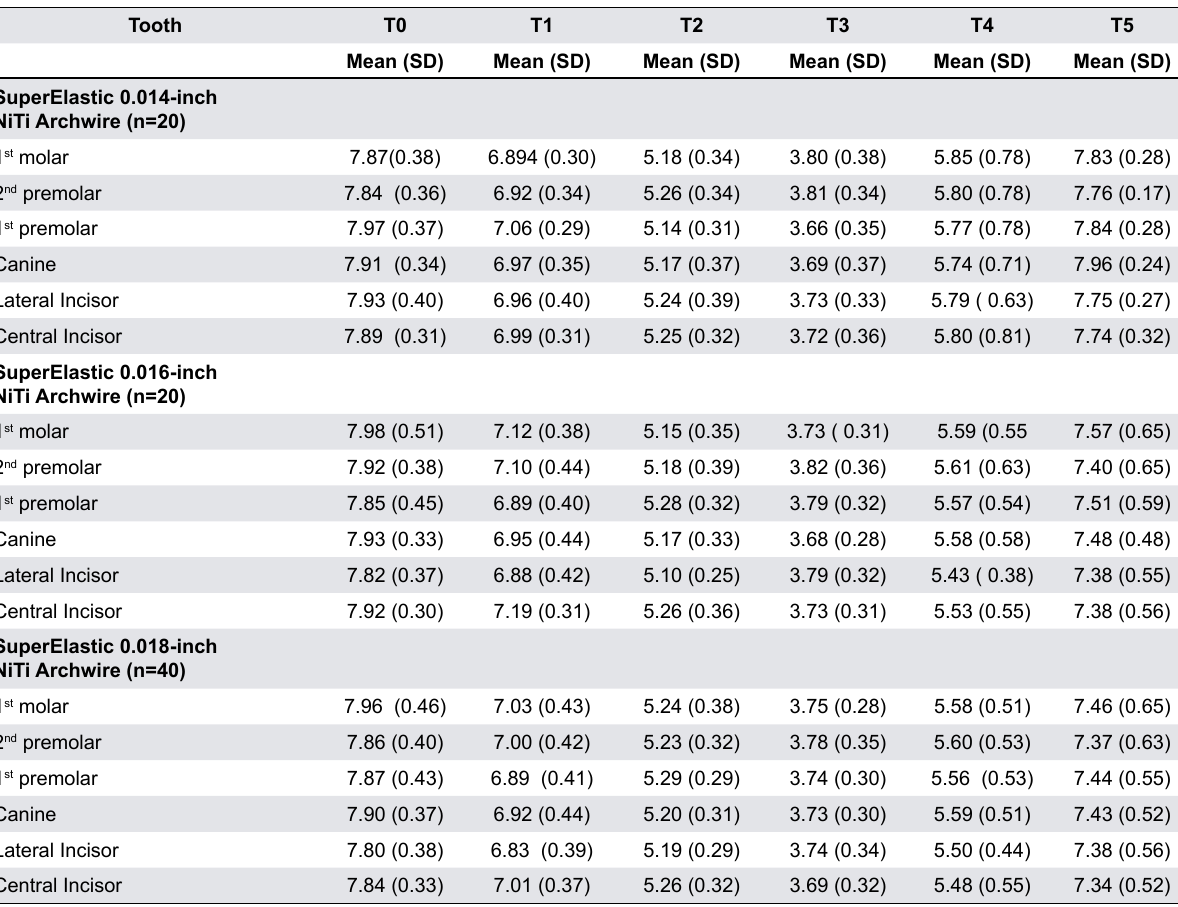
Table 2- Diff. between means and p-values for the PBF from baseline (T0) to (T5) for each measured tooth in 0.014-inch NiTi